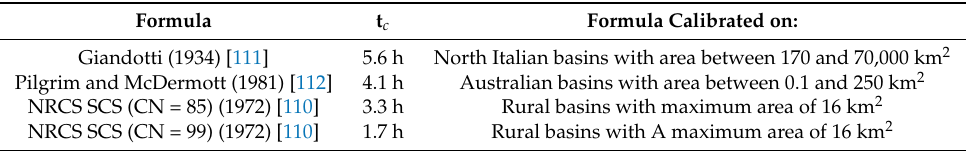
Table A2. Time of concentration ( t c ) estimates.